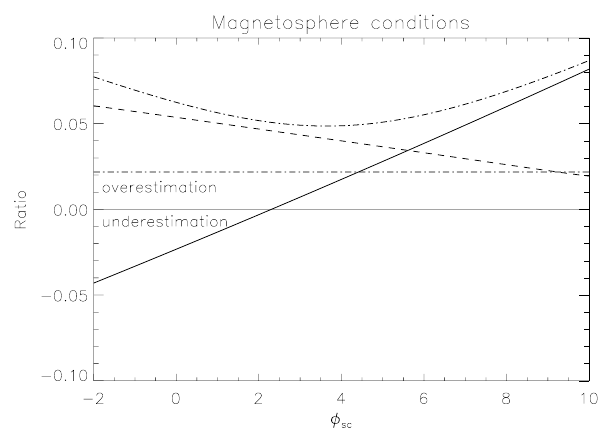
Fig. 5. Estimation ratios as in Fig. 3 but for the magnetosphere case: r N (solid line), r v (dashed line), r T (dot-dashed line). The upper curve is the estimation index I e